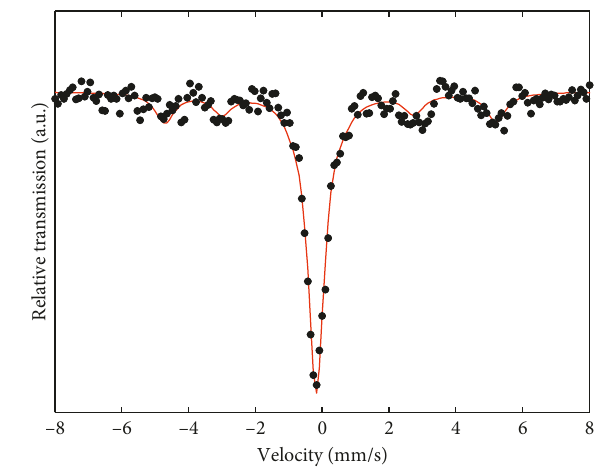
Figure 6: Change in relative density (with standard deviation) of sintered alloys (a) before annealing without preceding MA treat- ment, (b) after annealing without preceding MA treatment, (c) before annealing with MA treatment, and (d) after annealing with MA treatment.